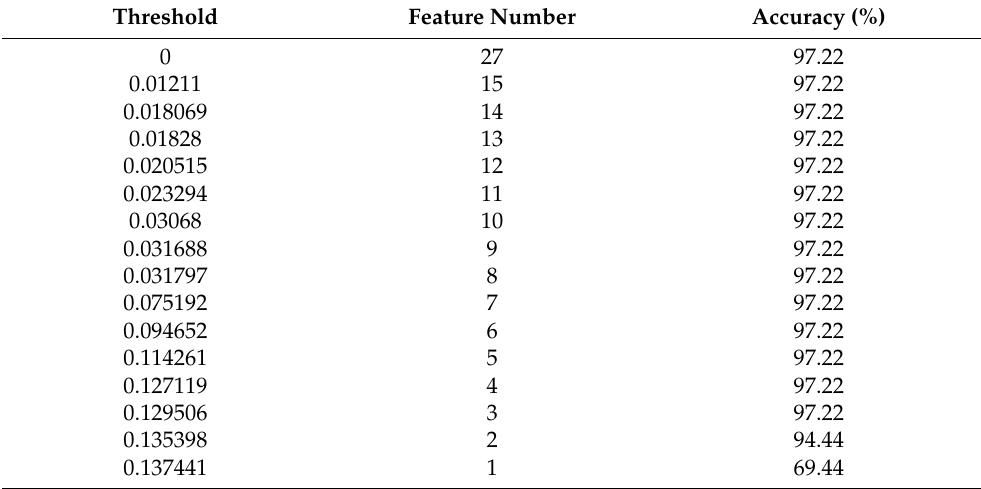
Table 4. Classification accuracy threshold obtained by using different color feature